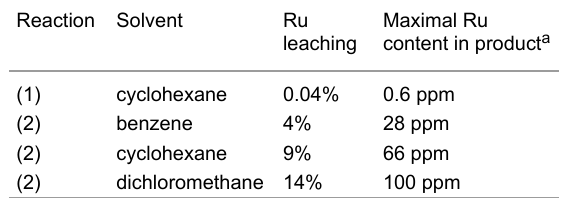
Table 1: Ru leaching for 3